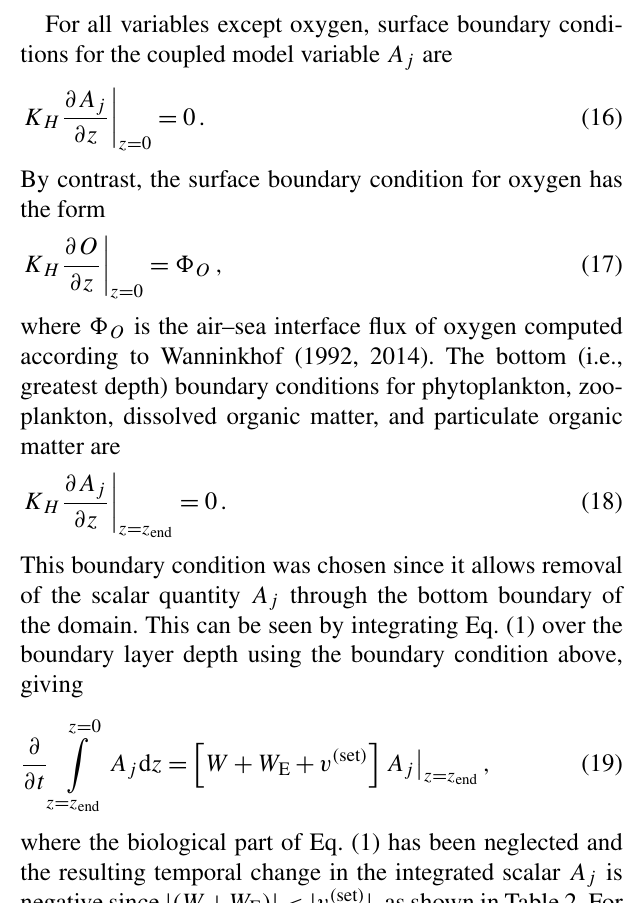
For all variables except oxygen, surface boundary